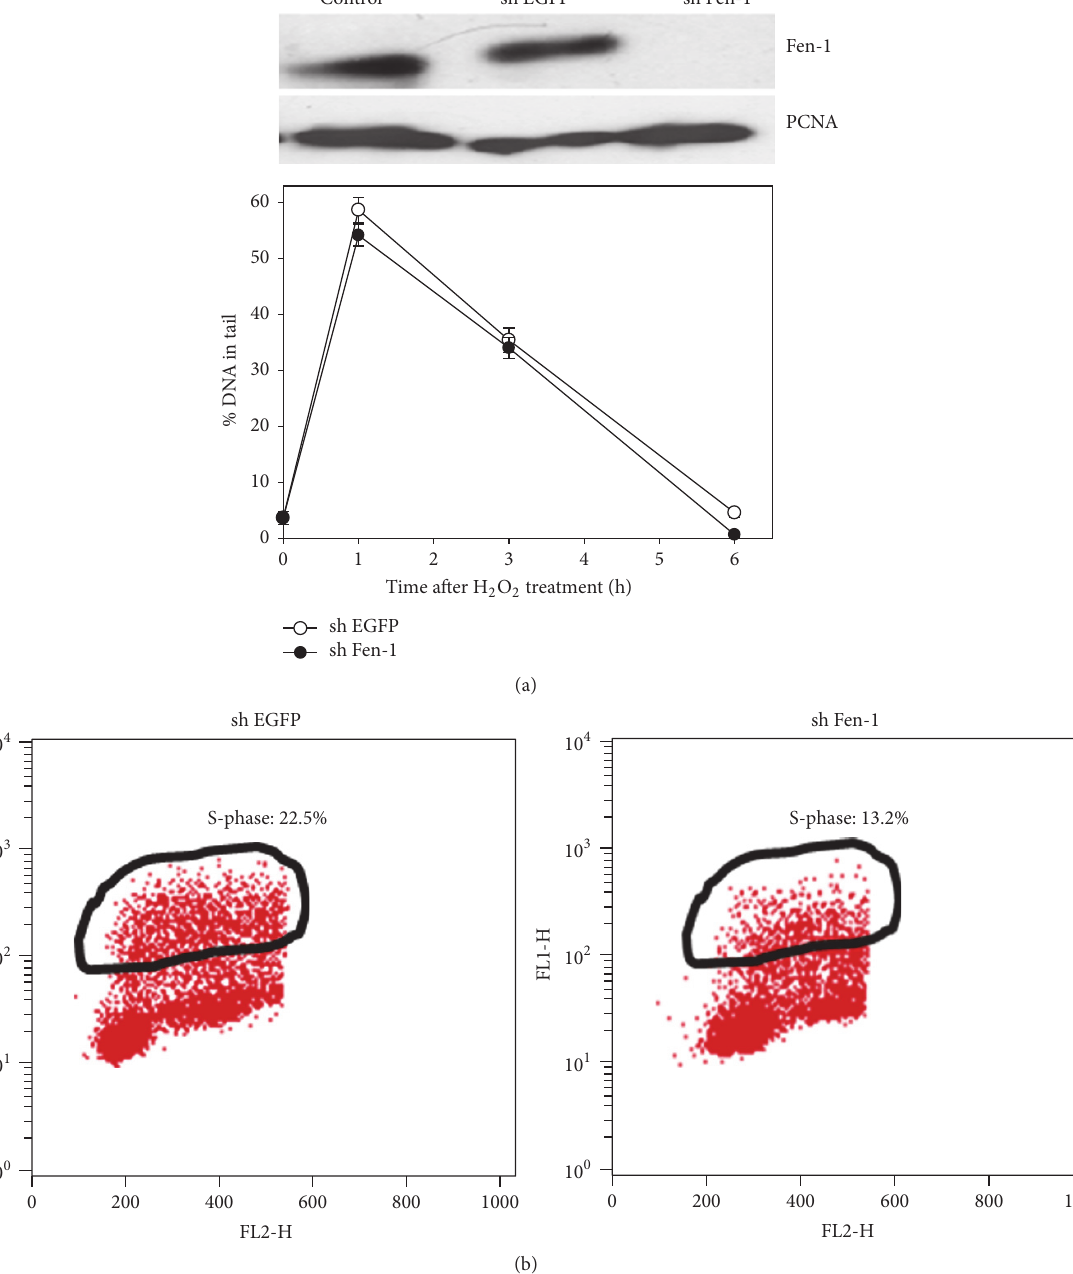
Figure 7: The effect of Fen-1 knockdown. (a) On repair of oxidative DNA damage. Top: western analysis of Fen-1 protein in AGS cells transfected with pLKO-1 sh Fen-1 to knock down Fen-1 or control vector; levels of PCNA protein were used as a loading control. Bottom: comet assay. AGS cells were treated with 20 𝜇 M H 2 O 2 for indicated periods of time before being harvested for comet-Fpg/Endo III assay. (b) On DNA replication. S-phase cells were